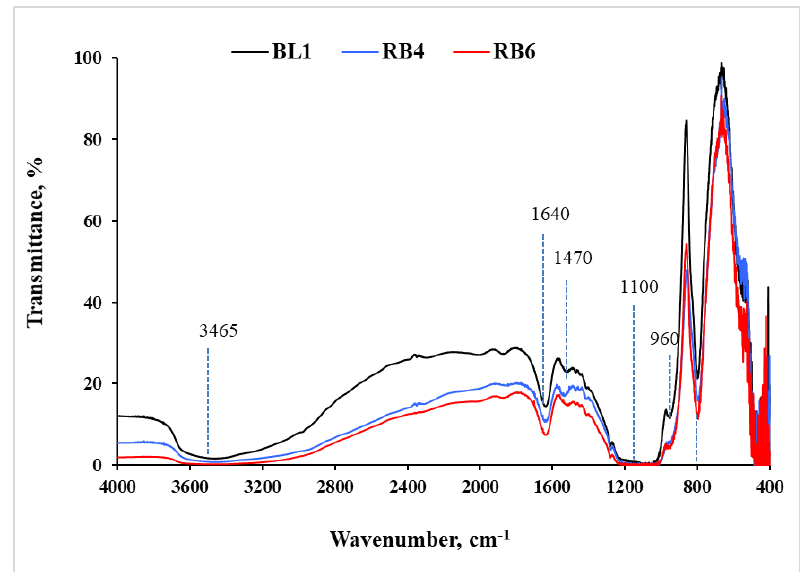
Figure 3. FTIR spectra of BL1, RB4 and RB6 matrices.